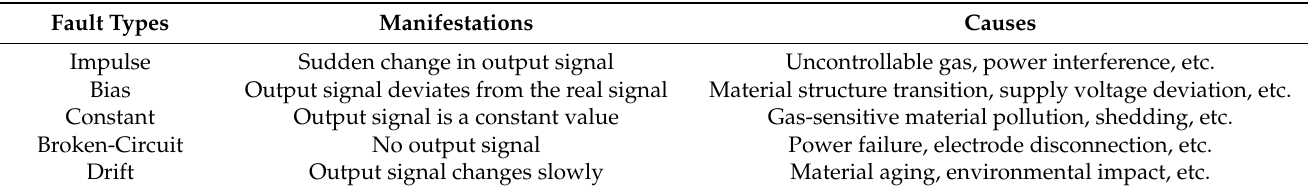
Table 1. The fault types and corresponding fault